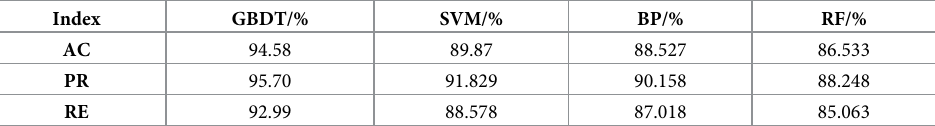
Table 6. Average disturbance recognition performance comparison for algorithms with different classification